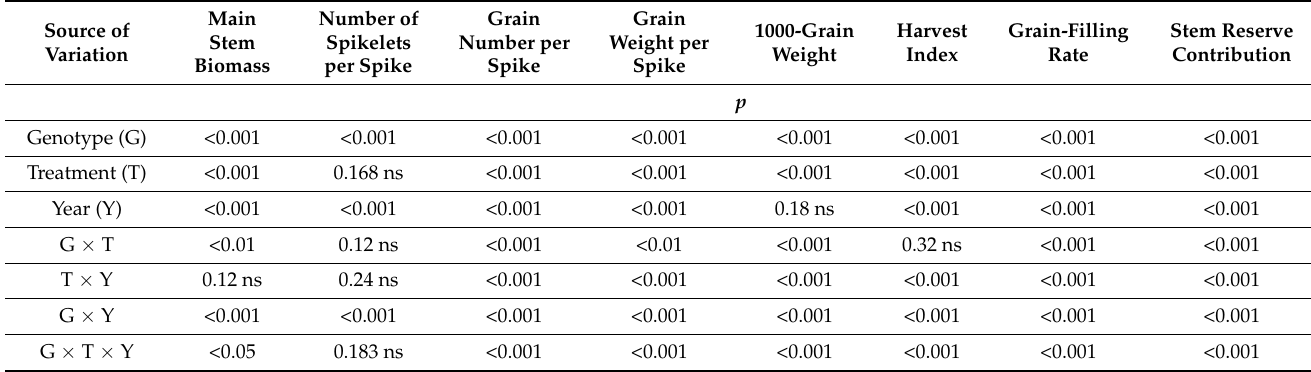
Table 4. Summary of ANOVA of the effect of genotype, treatment, and year on agro-physiological traits for the 20 wheat genotypes (standards, families, and